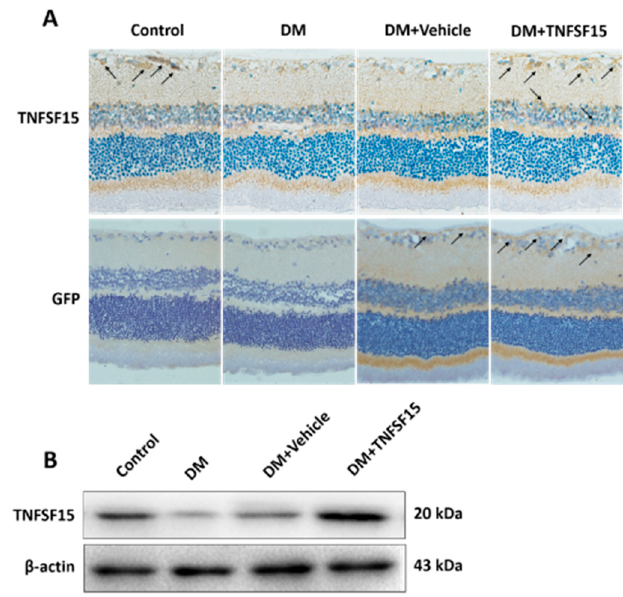
Figure 3. Intravitreal injection of LV-TNFSF15-GFP successfully overexpressed TNFSF15 proteins in the retina of rats. ( A ) Typical images of TNFSF15 and GFP immunostaining in the retina. Arrows indicate TNFSF15 ( upper panel) or GFP ( lower panel) expression in the retina. Magnification, 400×. TNFSF15 was abundantly expressed in the retina of rats treated with LV-TNFSF15-GFP, but almost deficient in rats treated with vehicle (LV-NC-GFP). GFP was abundantly expressed in the retinas of rats treated with LV-TNFSF15-GFP and LV-NC-GFP, but absent in the control and DM group; ( B ) The TNFSF15 protein level was assessed by Western blot, and a representative image is shown.